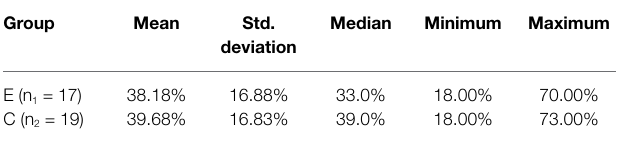
TABLE 1 | Descriptive statistics of the experimental (E) and control (C) groups in the pre-test.